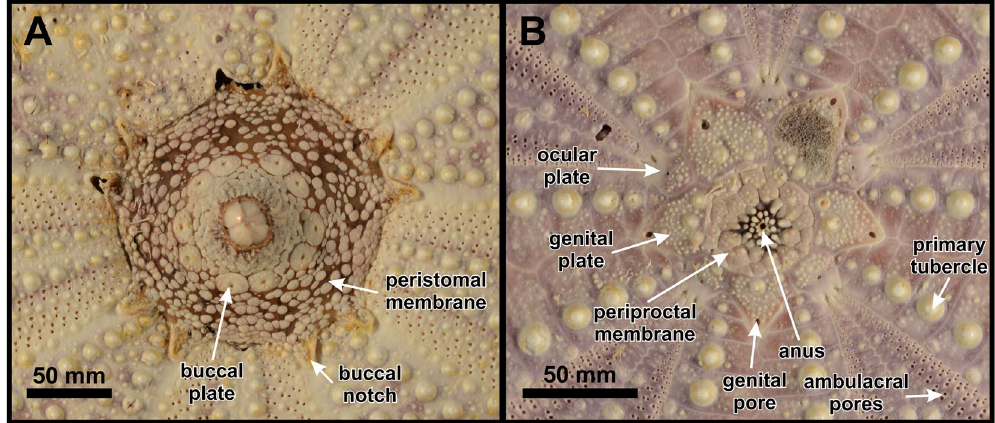
Figure 10. Peristome ( A ) and apical disc ( B ) of Tripneustes kermadecensis n. sp. Paratype (NHMW-Geo pores circular and located in outer half of the plates, about their own diameter from the margin. Madreporic pores minute, forming a well-defined, slightly raised patch. Periproct large (6.75 mm, ~7.2%TD), circular; densely covered with polygonal scales; anus almost central. Ambulacra trigeminate, compounded in echinoid style; pores forming three distinct vertical series, the inner- most of which are almost straight, while the other two are distinctly wiggling. Primary tubercles occurring on every other plate close to the peristome, every third plate in the outer half of the oral surface, and on every fourth plate ambitally (Figs 3 and 4C). Adapically primary tubercles typically occur on every third plate. Numerous ambulacral plates are occluded from the perradial suture, typically those located immediately below and/or above the plate bearing the ambulacral primary tubercles, forming a “pseudo-polyporous” arrangement (sensu Mortensen 25 ). Plate occlusion and enlargement of plates in between leads to rather irregular zigzagging of the perradial suture (Fig. 4C). Aboral ambulacral pores belong to type P2 (sensu Smith 41 ), with comparatively narrow attachment areas, whereas oral ones have distinctly wider attachment areas and approach type P3. Interambulacra fully tuberculate on oral side with up to five subequal tubercles per plate in the subambital region. At the ambitus, the size of the enlarged secondary tubercles diminishes rapidly, with almost none occur- ring beyond six plates above the ambitus. The primary tubercle columns, in contrast, persist as large, prominent tubercles with areoles taking up most of the plate height. Primary and secondary tubercles with well-developed areoles; secondary tuberculation very dense, especially so in the ambulacra. Peristome large (25.7 mm, ~27.2%TD), circular, with prominent buccal notches (without distinct tag) that extend to the third interambulacral tubercle; peristomal margin barely sunken (Fig. 3E). Buccal membrane densely plated close to the mouth opening; buccal plates form broken circle; plating outside of buccal plate circle is less dense, with gaps of up to a single plate width around each platelet, but becomes denser at peristomal margin again; platelets of the buccal membrane bear numerous pedicellariae, but no spines (Fig. 10). Lantern of typical camarodont type with large foramen magnum and fused epiphyses; rotulae rectangular with poorly differentiated triangular part adaxially; compasses showing short bifurcations distally, which are compar- atively flattened and wide (Fig. 11). Auricles connected at top, relatively wide. Primary spines up to 15.5 mm in length; almost straight sided in proximal half and slightly tapering to a blunt point distally; bases very high (almost 1.7 times their width) and slightly constricted below milled ring; in cross-section spines consist of dozens of wedges forming concentric circles. Microsculpture of wedges in primary and secondary spines saw-tooth-like, minute (Fig. 2K–M), very similar to that of T . ventricosus . Tridentate pedicellariae apparently absent; globiferous pedicellariae (Fig. 2A–E) abundant, with single, large and curved end-tooth and a long neck; basal part of globiferous pedicellariae with teardrop-shaped outline; stalk glands present; ophiocephalous pedicellariae (Fig. 2F–J) very abundant, with fully denticulate margin; triphyllous pedicellariae present, not specialized. Spicules in tubefeet mainly of large, C-shaped type; dumb-bell shaped spicules present, but deeply embedded in skin and usually not apparent in BSE-SEM images. Aboral coloration of naked corona light pink to light violet; darker along perradial and interradial sutures; outer margin of apical disc traced by a distinct reddish-pink line; oral side less colored, white along the perradial and interradial sutures, as well as the pore zones, only the area adjacent to the interambulacral primary tubercles more intensely colored. Living animals black with dense cover of white spines (Fig. 3A); spine posture radial, not bent over ambulacra under normal conditions. Additional description based on paratypes and other material. Corona large, reaching up to 130 mm in horizontal diameter, with test height ranging from 46.7 to 61.2%TD (mean = 51.2, SD = 4.2, n = 11). Apical disc usually hemicyclic, with oculars I and V insert. In the largest specimen (TD = 127.7 mm), however,